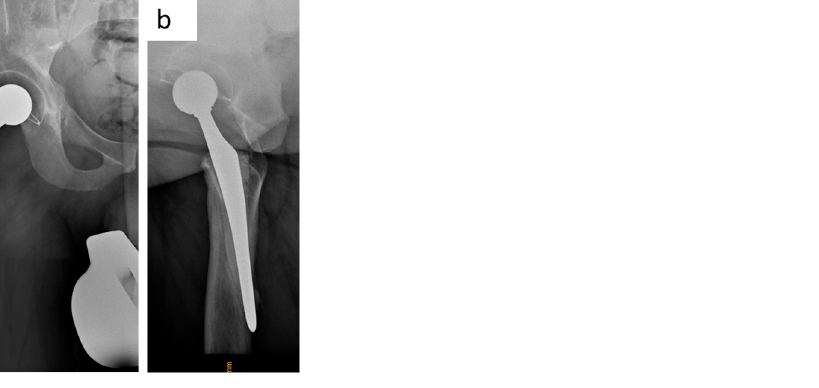
Figure 5. Anteroposterior ( a ) and axial ( b ) views of the right hip before THA revision. The patient